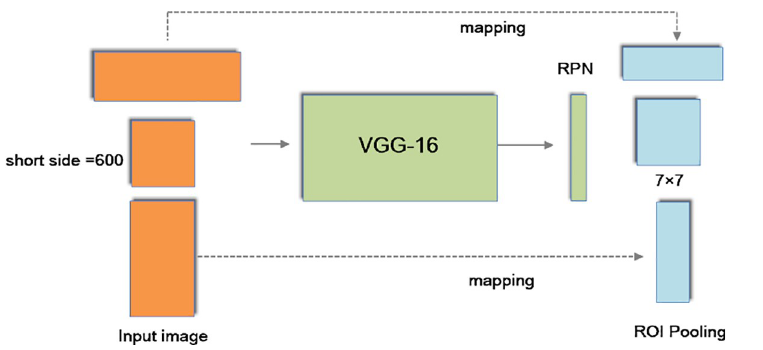
Fig 5. The enhanced pooling